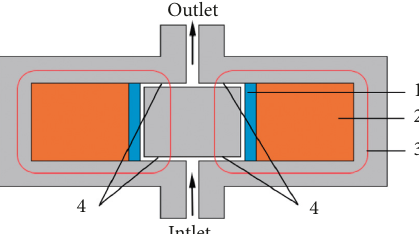
Figure 31: Cross-sectional view of MR valve with radial gap based on single-stage flow mode: 1, magnetic isolation ring; 2, magnetic coil; 3, magnetic flux; 4, radial gap